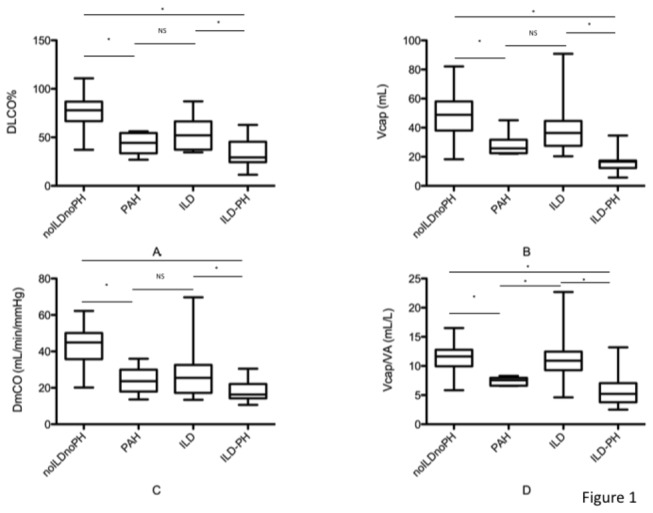
Comparison of DLCO% of predicted (panel A), Vcap (panel B), DmCO (panel C) and Vcap/VA ratio (panel D) between SSc patients with PAH, ILD, both ILD and PH (ILD-PH group) and no complications (noILDnoPH group).NS: non significant; *: p<0.05.